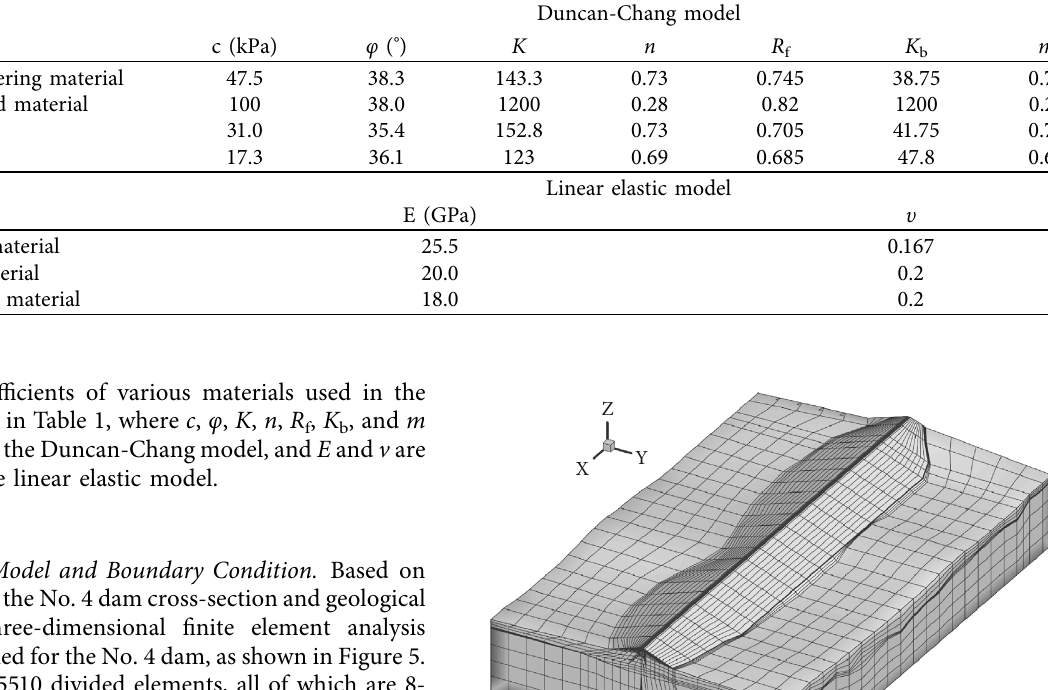
Table 2: Constitutive parameters of various materials of the dam.